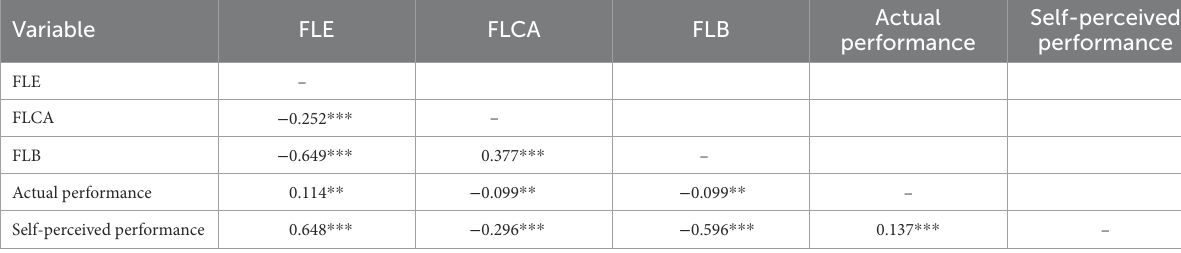
TABLE 2 Correlations between FLE, FLAC, FLB, and online learning performance.